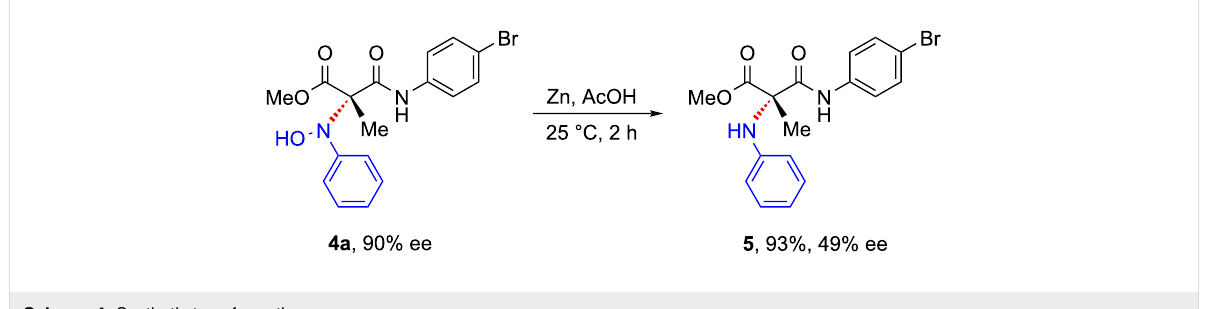
Scheme 4: Synthetic transformation.